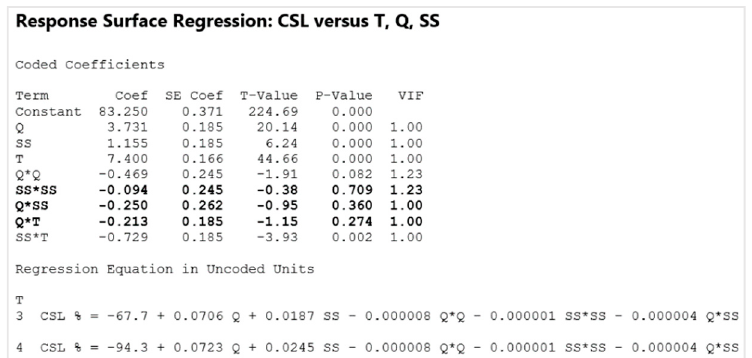
Figure 10. CCD—response surface regression of the customer service level (CSL; %) versus T, Q, and SS.